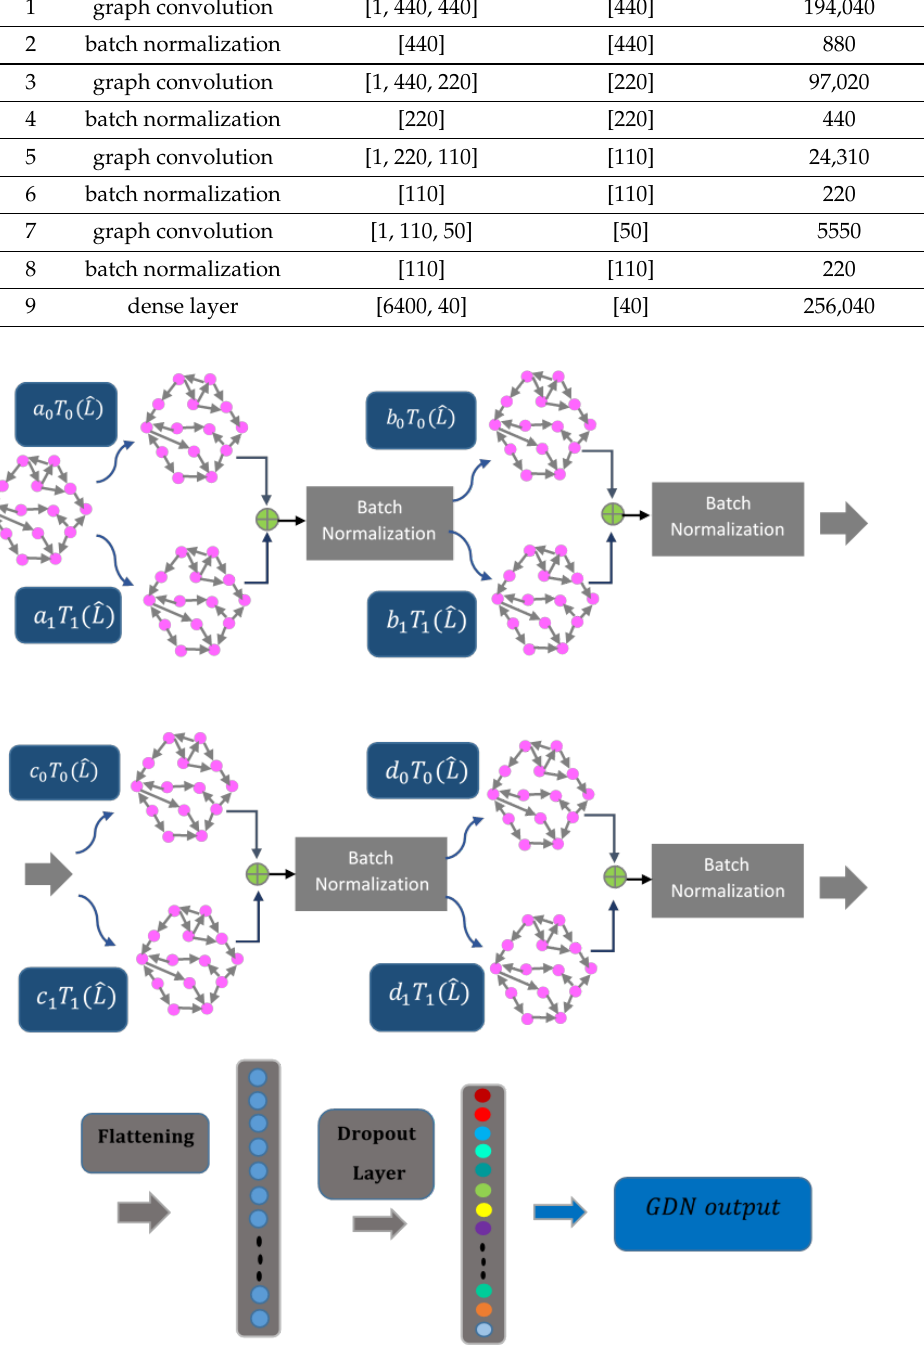
Figure 3. The network architecture of the GDN part of the proposed